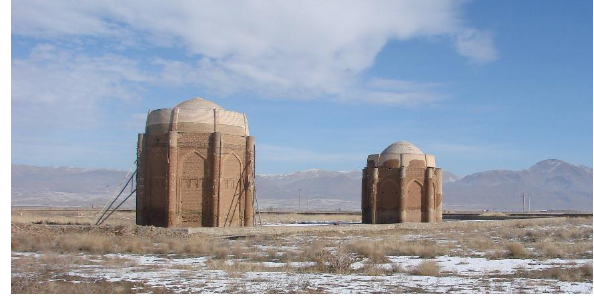
Figure 3. Southern view of Kharraqan Tomb